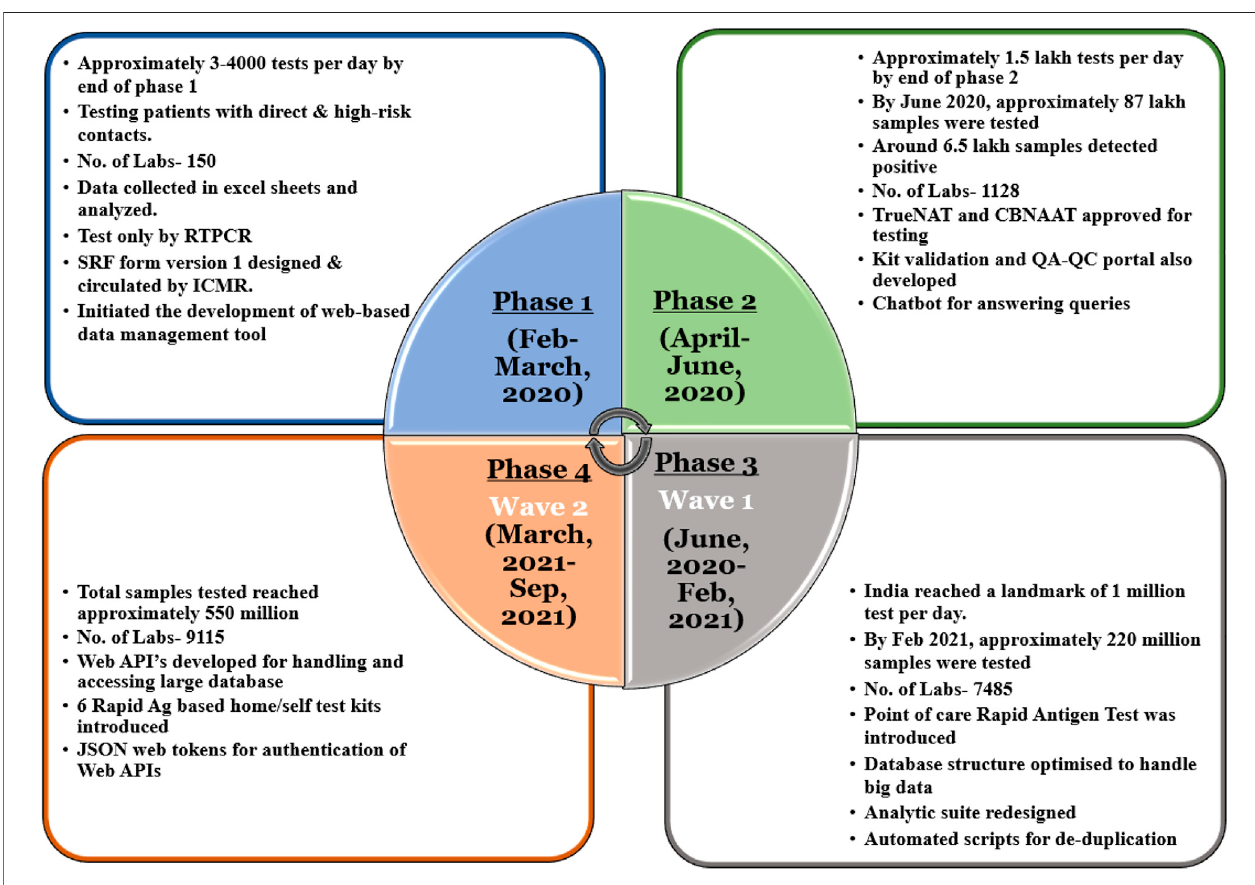
FIGURE 1 | Phase-wise evolution of data management for COVID-19 in India.